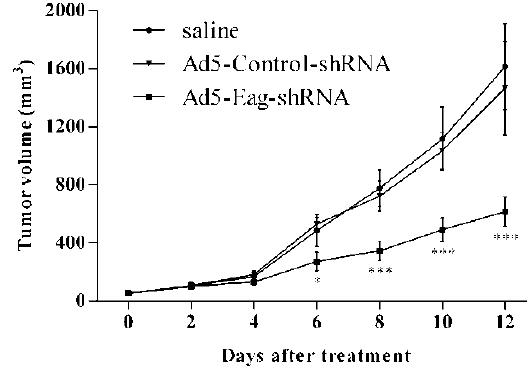
Figure 2. Eag1 silencing inhibits the growth of a MG-63 derived tumor in nude mice. Intra-tumor injection of Ad5-Eag1-shRNA significantly reduced the size of MG-63 derived tumor implanted subcutaneously in nude mice during the 12-day follow-up period as compared with the saline control and the Ad5-Control-shRNA. * p < 0.05, *** p < 0.001, compared with either the saline control or the Ad5-Control-shRNA ( n =